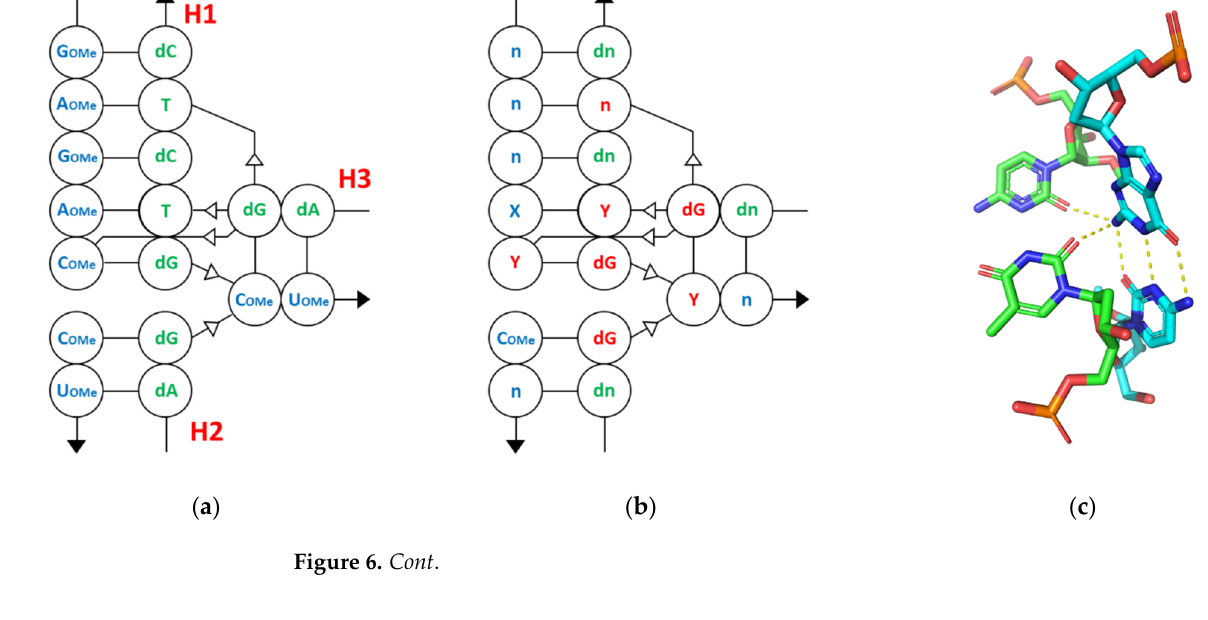
( d ) Figure 6. 3wj-YdG interaction: ( a ) original motif sequence; ( b ) secondary structure pattern; ( c ) 3D representation of 3wj-YdG interaction derived from pdb:7osx; ( d ) tertiary structure in stereoscopic 3D view (parallel). Hydrogen bonds are indicated by yellow dashed lines. 3.2. Structural Features of DNA:2 ′ -O-Me-RNA Duplexes